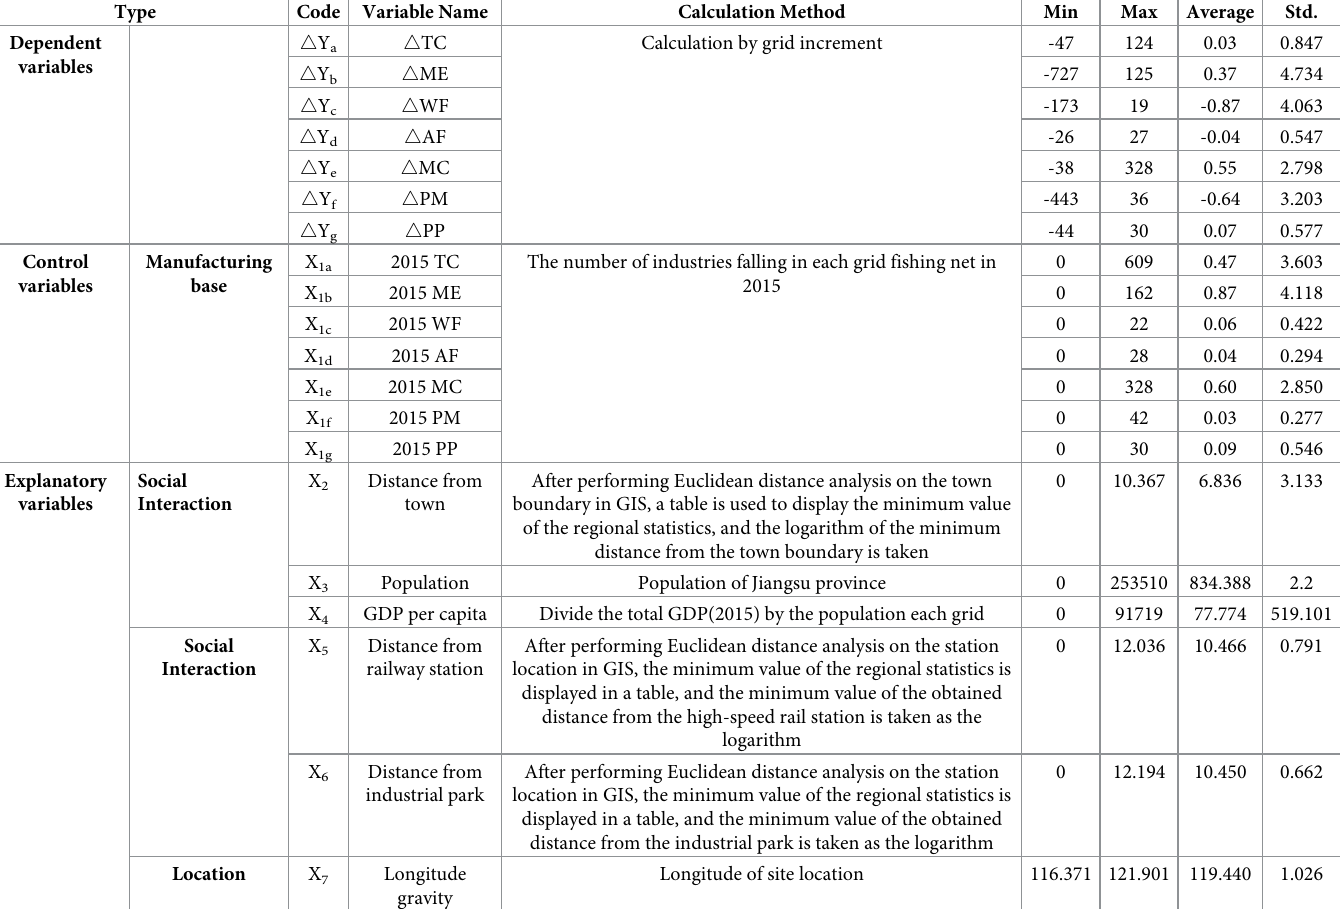
Table 1. Data sources and descriptive statistics of various industry driving forces.